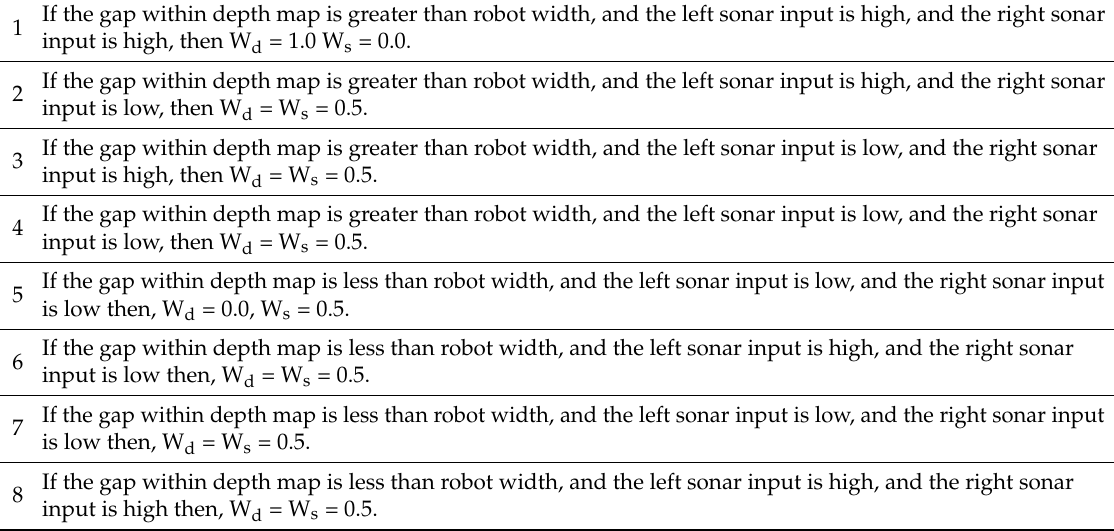
Table 3. Fuzzy rules for combining sensors.